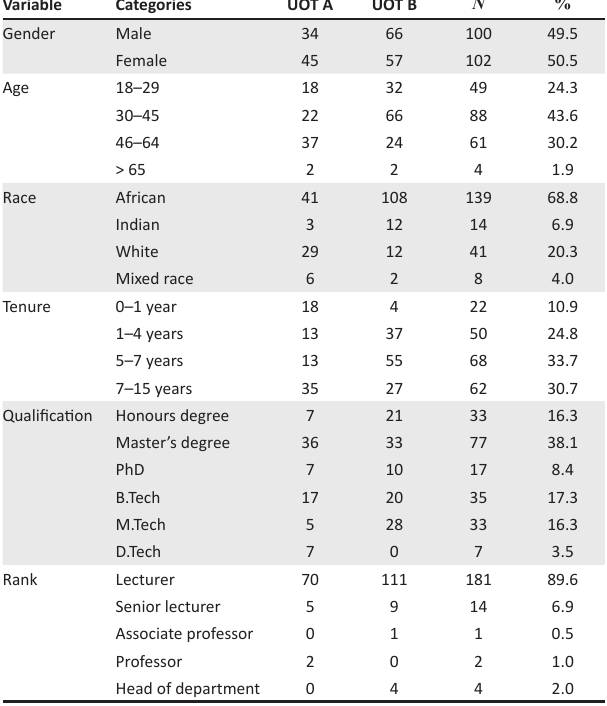
TABLE 1: Demographic profile of respondents ( N =